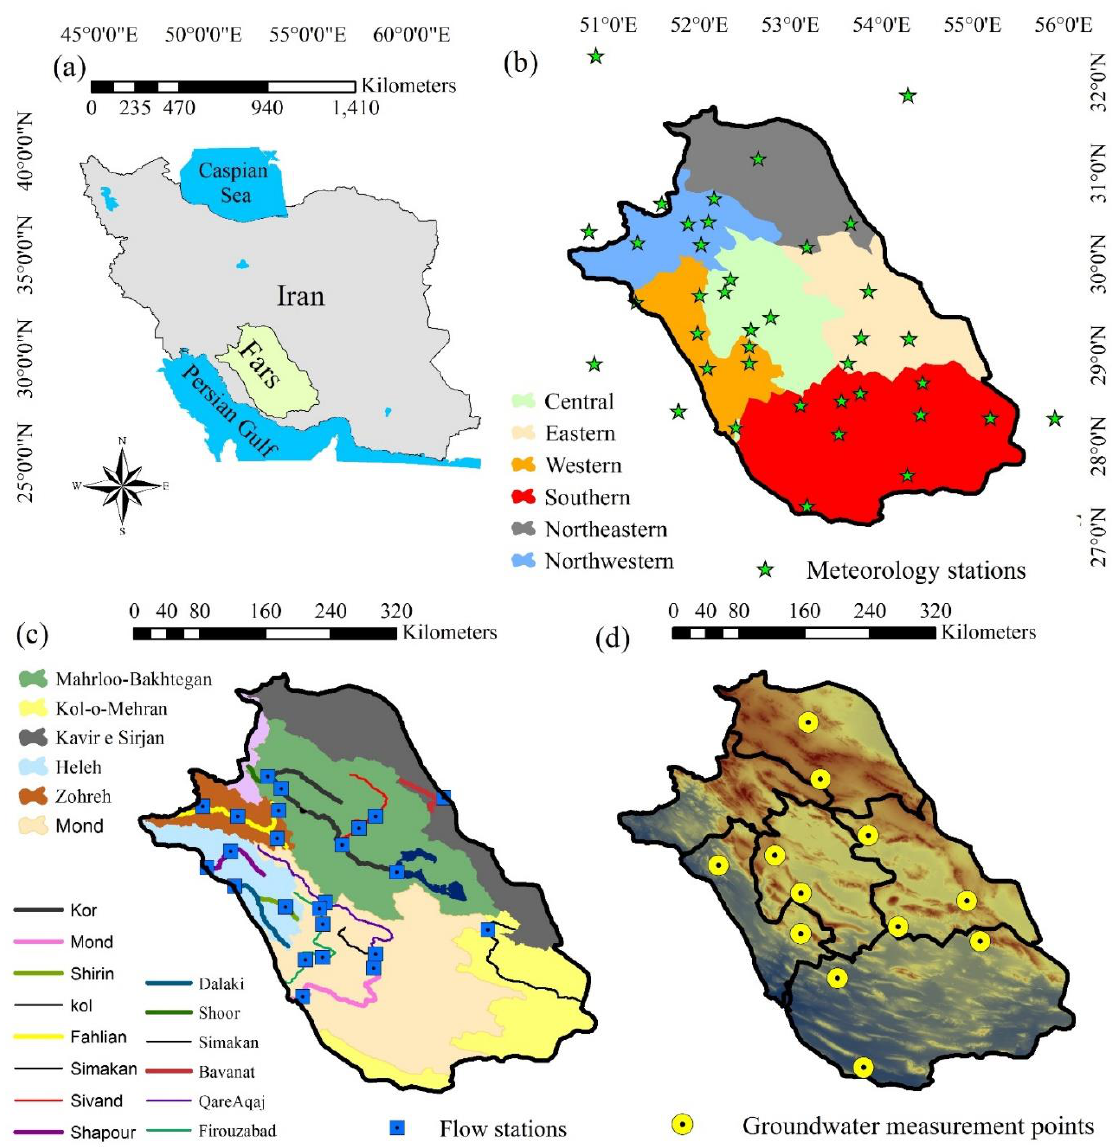
Figure 1. Maps showing ( a ) the location of the study area—Fars province in Iran; ( b ) its six regions with 38 meteorological stations; ( c ) major basins and rivers with 24 hydrological stations; and ( d ) topography and 12 groundwater measurement points. For more details of measurement points, see Appendix A.